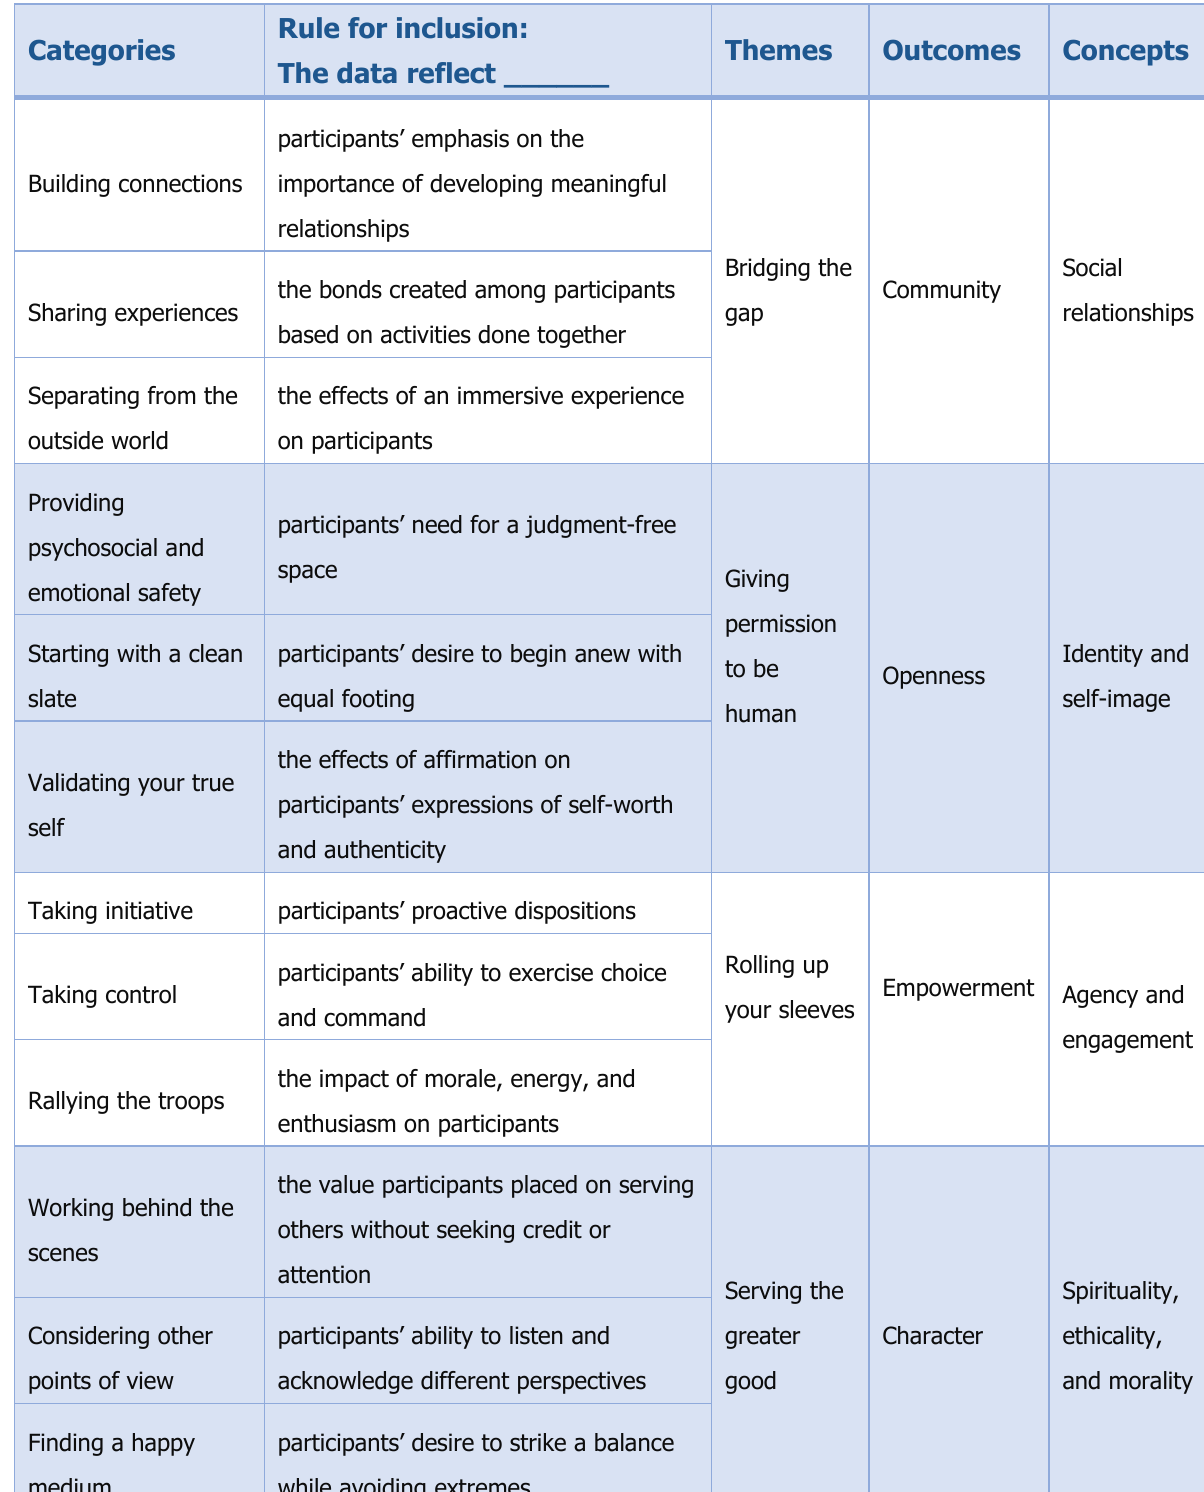
Table 3. Alignment of Categories, Rules for Inclusion, Themes, Outcomes,